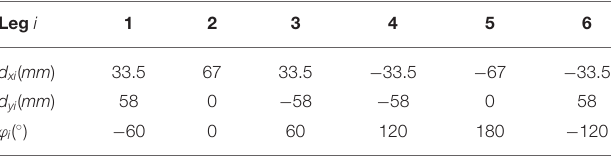
TABLE 2 | Transformation parameters from the